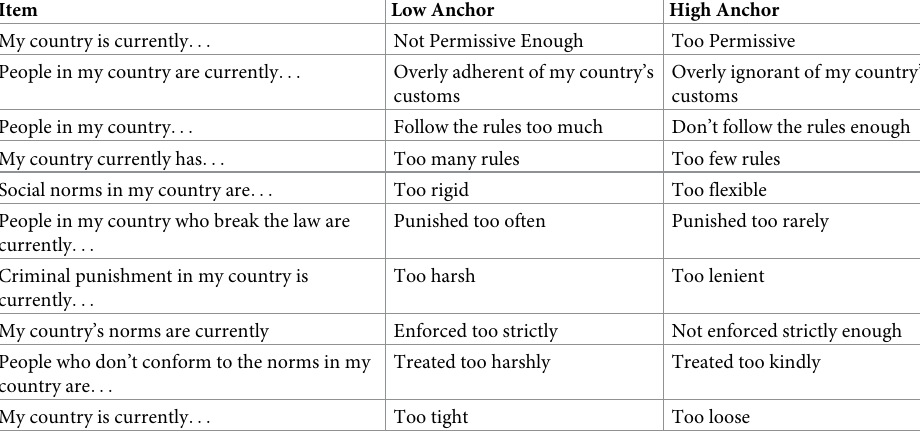
Table 1. Items in support for cultural tightness